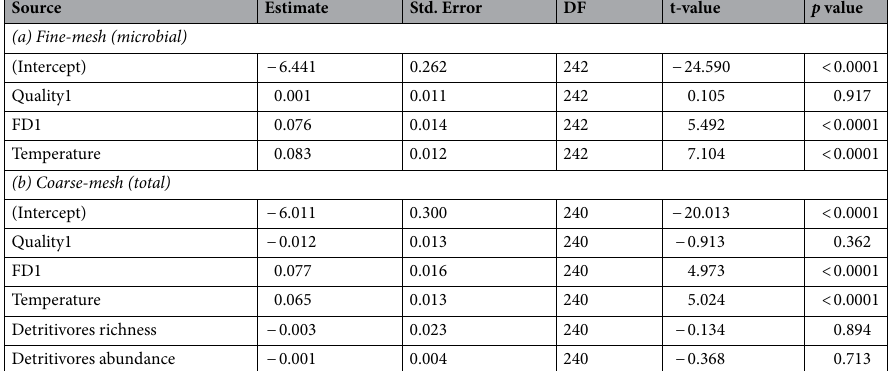
Table 2. Results of linear mixed effect models examining how decomposition rates changed in response to litter quality, litter functional diversity (FD) and temperature in (a) fine-mesh bags and (b) coarse-mesh bags. Interaction between Quality1 and Temperature, and FD1 and Temperature were not significant, thus were removed to increase model robustness. Quality1 and FD1 are the first PCA axes on the mean trait values and Rao’s Q values, respectively. Richness and abundance of detritivores collected inside the coarse-mesh bags were included in the coarse-mesh model as covariates. Fine-mesh marginal R 2 = 0.26, conditional R 2 = 0.26. Coarse-